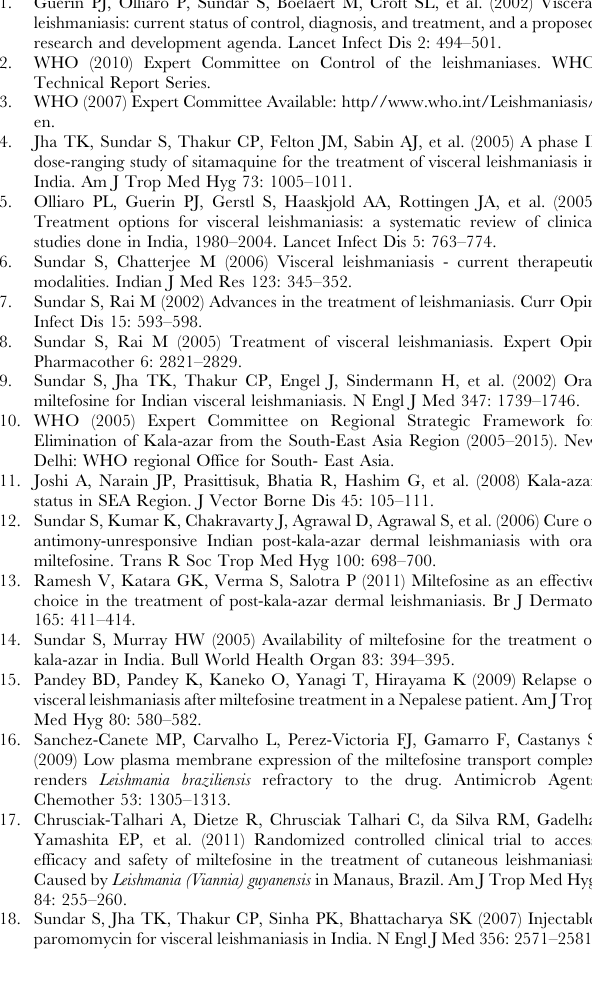
Table S1 Primer sets employed to test for the point mutations of